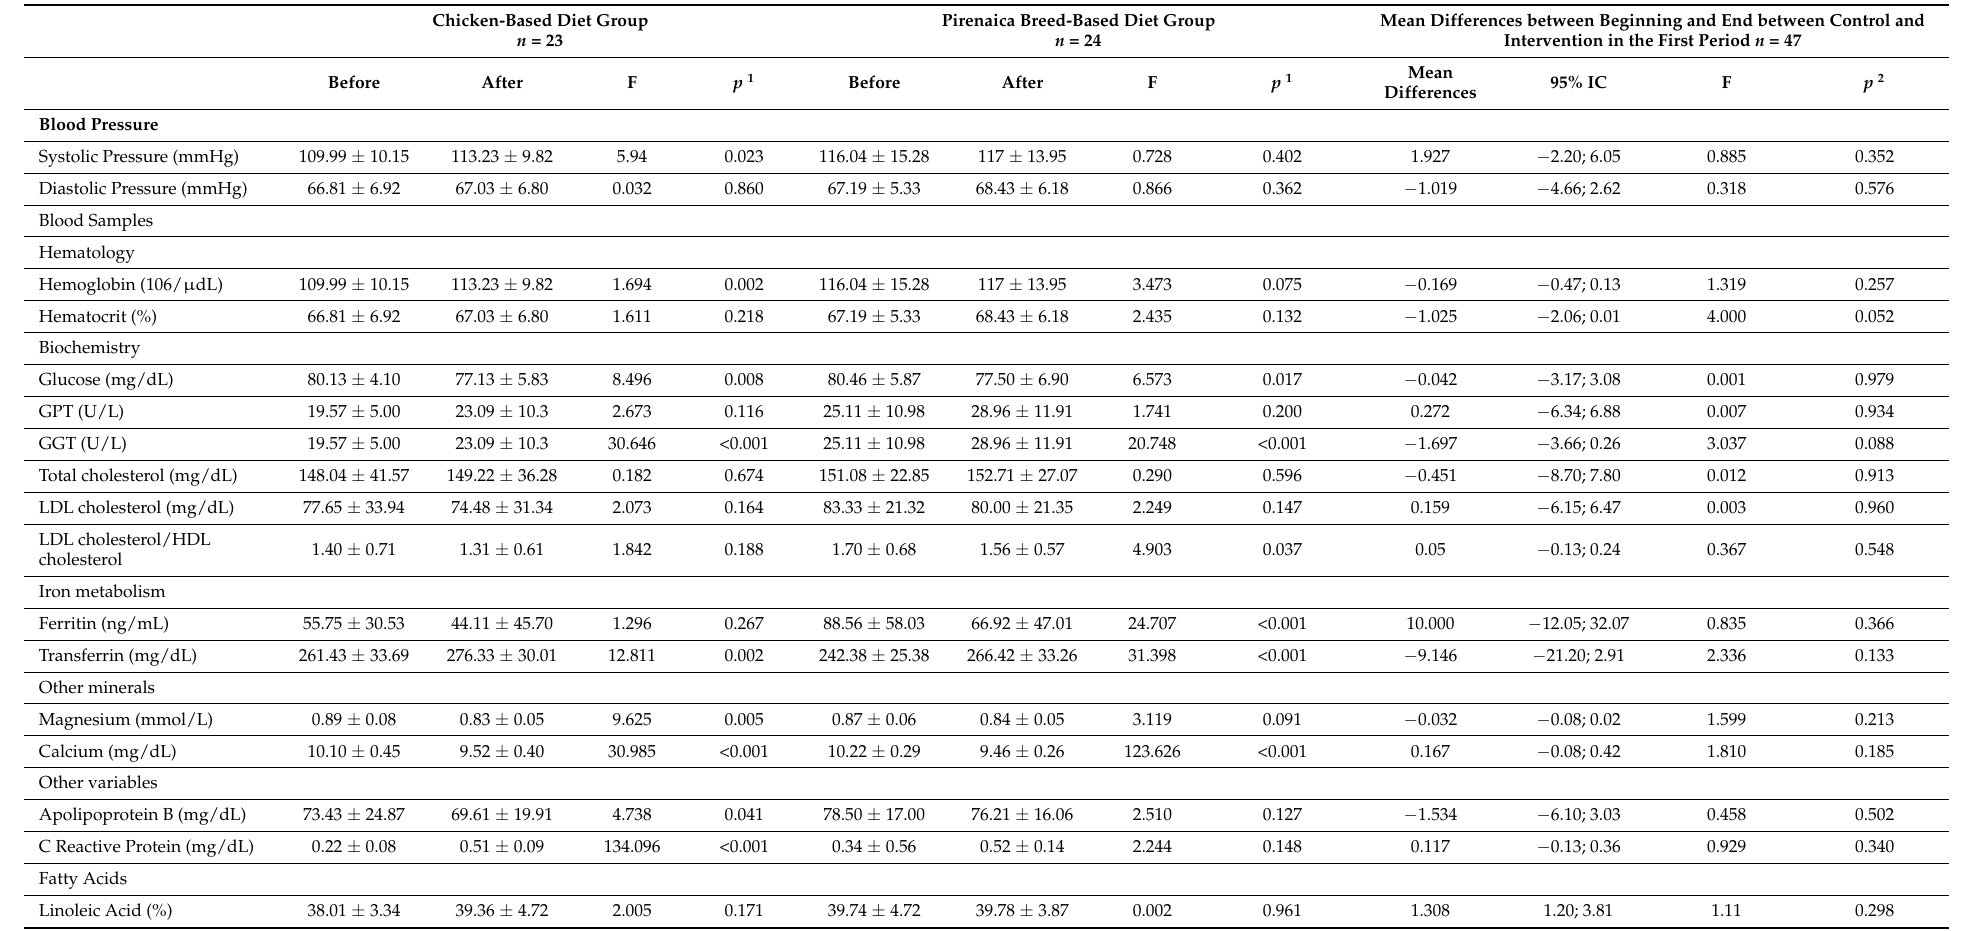
Table 4. Mean values of body composition, blood parameters and mean differences over time between both groups in the first period of the study. Chicken-Based Diet Group n = 23